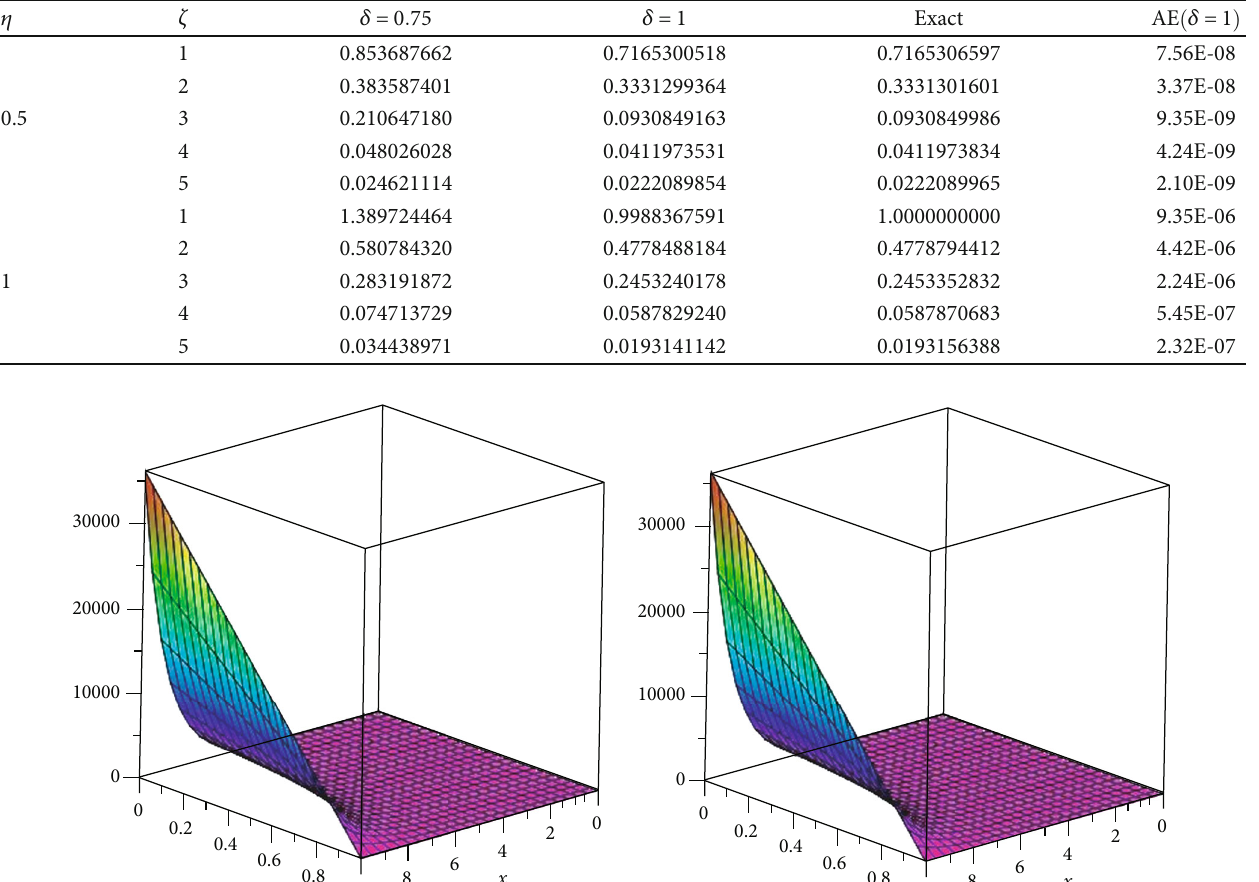
Table 1: VITM at fractional-order value δ = 0 : 8 and absolute error δ = 1 of example 1.